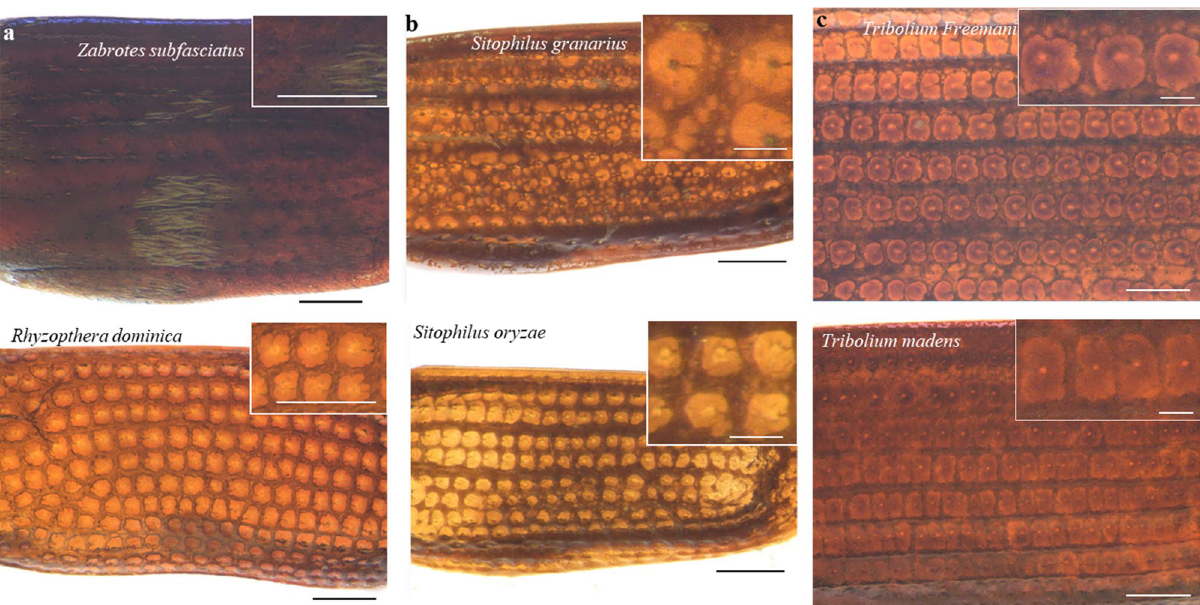
Figure 8. Extending this imaging method to other species of food contaminating beetles. Elytra images of species belonging to (a) two completely different families; (b,c) of same genus. Sitophilus granarius and Sitophilus oryzae of genus Sitophilus ; T. freemani and T. madens of genus Tribolium . The optimized imaging technique works well for imaging elytra of most species of pantry beetles. However, species with variegated dorsal setae and deep concave shapes are most difficult to image properly. The images are at 100x magnification, with the scale bars being 250 µm; the insets show the magnified patters with scale bar being 100